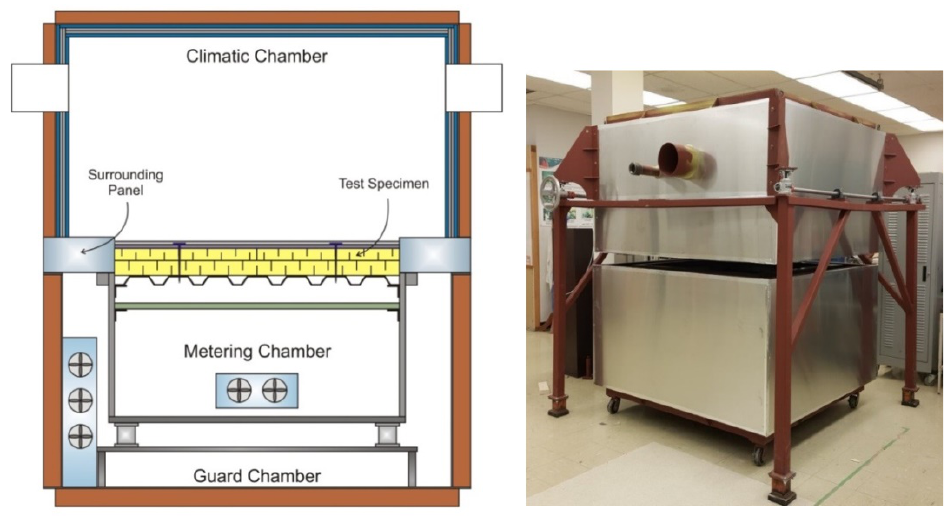
Table 1. Design insulation nominal thickness for achieving the respective thermal resistance. Board Thickness R-25.21 R-30.21 R-35.21 Polyisocyanurate (polyiso) [2 in + 2.5 in] [2 in + 3 1/3 in] [2 in + 4 in] 51 mm + 64 mm 51 mm + 84 mm 51 mm + 102 mm Expanded Polystyrene (EPS) [3 1/8 in + 3 1/8 in] [3 7/8 in + 3 7/8 in] [4.625 in + 4.625 in] 80 mm + 80 mm 98 mm + 98 mm 117 mm + 117 mm Rockwool [2.5 in + 4 in] [4 in + 4 in] [5.5 in + 4 in] 64 mm + 102 mm 102 mm + 102 mm 140 mm + 102 mm Note: R26, R31, and R36 are effective thermal resistances that include outside and inside air films. Excluding air films, the designed thermal resistance for the roofing assemblies are R35.21, R40.21, and R46.21.